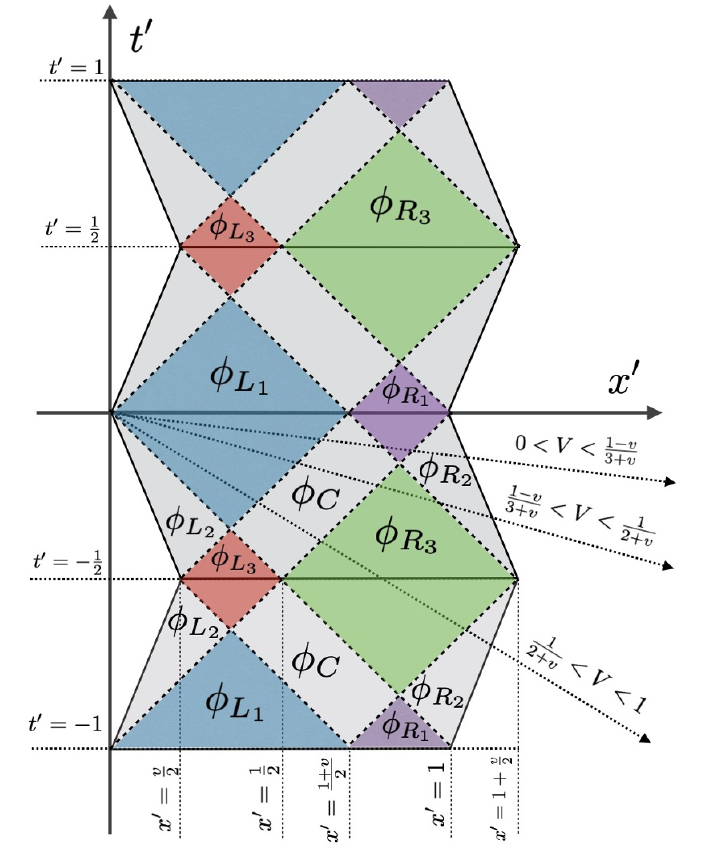
Figure 1 . The world sheet of the generalized exact oscillon seen in its own rest frame S 0 . Only in (cid:2) (cid:3) the interval t 0 2 0 ; 1 (cid:30) k = ’ k holds; other partial solutions are given by (2.9). The axes x of the 2 laboratory reference frame seen in frame S 0 have an inclination with respect to axis x 0 . Here we present three di(cid:11)erent cases of inclination corresponding to the velocity u 0 = (cid:0) V of the laboratory frame S that moves to the left on the diagram S 0 . The angle of this inclination between axes x 0 and x is given by arctan( V